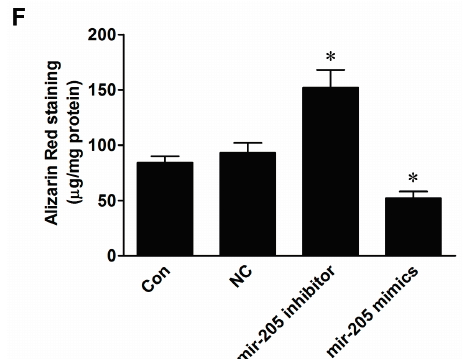
Figure 2. Effects of mir-205 on the osteogenic differentiation in BMSCs. ( A , B ) Bone sialoprotein (BSP) and osteopontin (OPN) protein expression after treatment with negative control (NC), mir-205 inhibitor or mir-205 mimics; ( C ) Alkaline phosphatase (ALP) activity was determined by ALP assay and expressed relative to total cellular protein; ( D ) Osteocalcin levels were measured by enzyme-linked immuno sorbent assay (ELISA) and expressed relative to total cellular protein; ( E ) Alizarin red S (ARS) staining images were shown at day 14. Scale bar = 200 μ m; ( F ) Semi-quantity analysis of ARS staining. Data are depicted as mean ± SD, * p <0.05 vs.